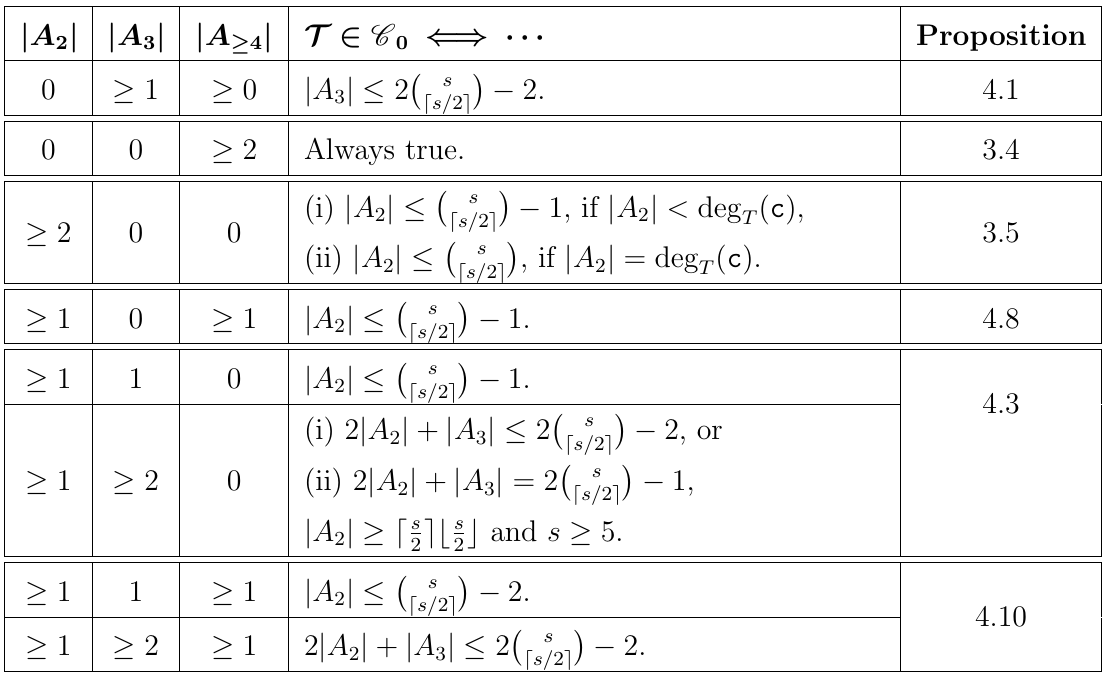
Table 3: Summary for T = T